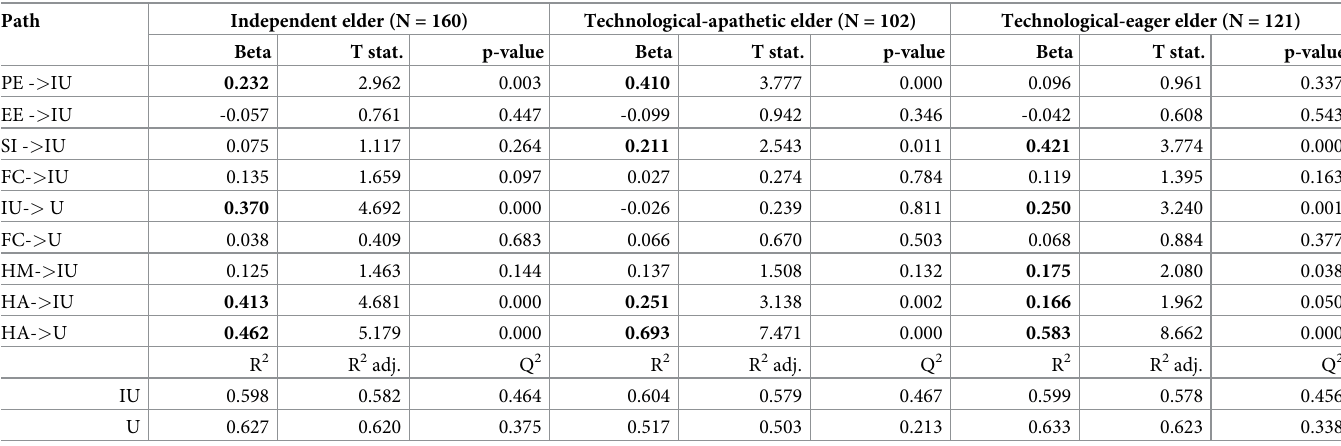
technological-apathetic elder with the technological-eager elder groups, the results indicate a score correlation of 0.984 for the FC construct, which is greater than the 5% quantile of 0.983. The results show the same pattern for each construct when comparing between groups. These results allowed us to proceed with the PLS-MGA. Table 11 shows the PLS-MGA results for the model with all three segments. PLS-MGA allows us to verify if the predefined datasets have sig- nificant differences in their estimates of group-specific parameters. In particular, we examined Table 10. Path coefficients for each